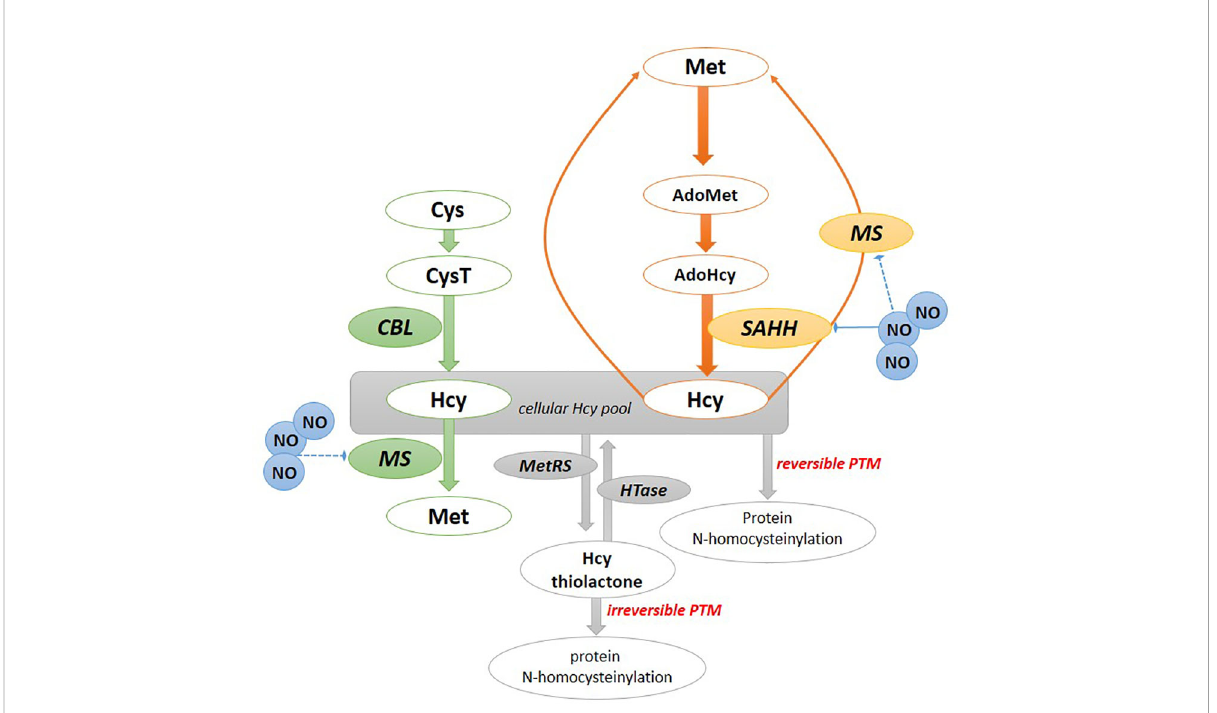
FIGURE 1 Homocysteine formation and mode of action in plants. The chloroplast pathway of Hcy formation (in green); the cytosolic pathway of Hcy formation (in orange). Hcy can be converted to Hcy-thiolactone, which modi fi es proteins by N -homocyteinylation. Hcy can also bind to cysteine residues of a protein, forming a disul fi de bound resulting in S -homocysteinylation of proteins. AdoHcy, S -adenosylhomocysteine; AdoMet, S-adenosylmethionine; Cys, cysteine; CysT, cystathionine; CBL, cystathionine b -lyase; Hcy, homocysteine, HTase, Hcy-thiolactone hydrolase; MetRS, methionyl-tRNA synthetase; MS, methionine synthase; NO, nitric oxide; SAHH, S -adenosylhomocysteine